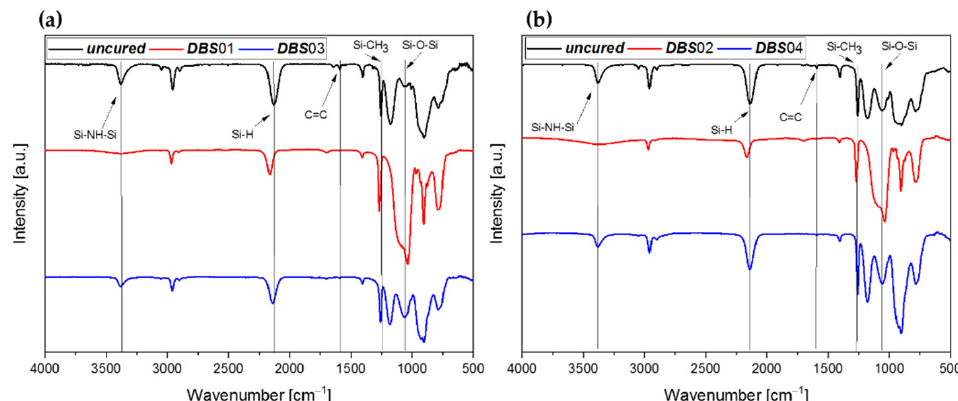
Figure 9. FTIR spectra of the uncured and cured Durazane 1800 sample mixed with DBS as photoini- tiator. The red curves were cured in ambient and the blue curves in nitrogen atmosphere. Black curves belong to the uncured sample. ( a ) DBS 01 and DBS 03, ( b ) DBS 02 and DBS 04 cured by the LED source ( λ = 385 nm).